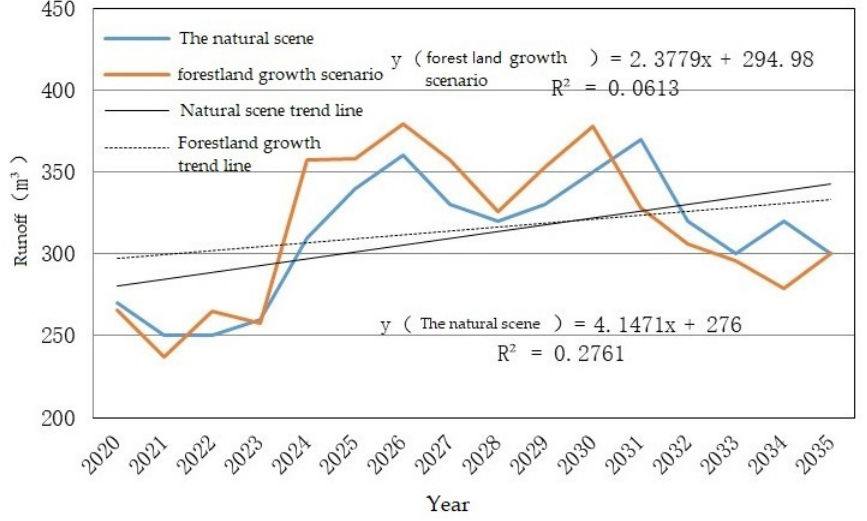
Figure 10. Future variation trend of runoff in the Hanjiang River basin of the Qinling Mountains in different